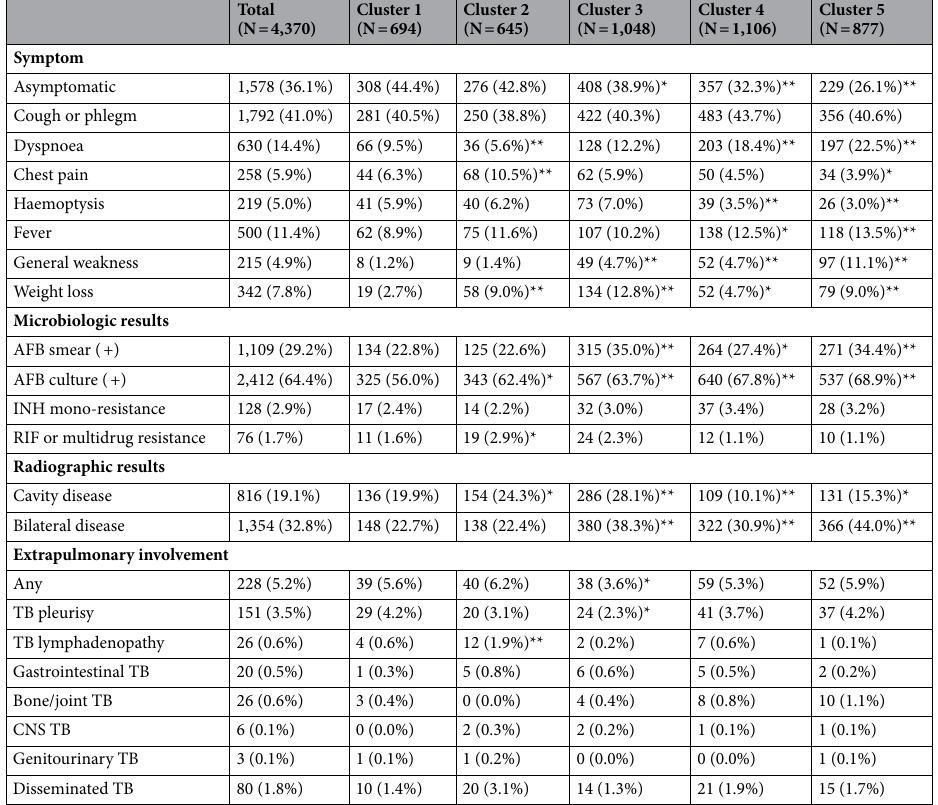
Table 2. Clinical, microbiological and radiographic profiles among clusters in patients with pulmonary tuberculosis. AFB, acid-fast bacilli; TB, tuberculosis; CNS, central nervous system; INH, isoniazid; RIF, rifampicin. *indicate statistical significance of P < 0.05. **indicate statistical significance of P < 0.01 compared to reference group of cluster